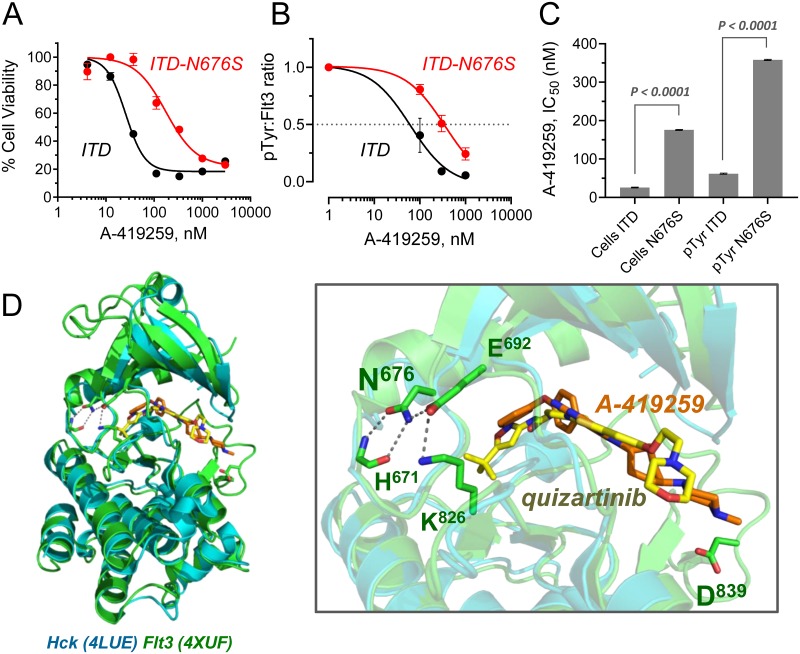
Flt3-ITD N676S mutation confers resistance to A-419259 in TF-1 cells.(A) TF-1 cells expressing Flt3-ITD or the Flt3-ITD N676S mutant were incubated over a range of A-419259 concentrations or the DMSO carrier solvent (0.1%) alone as control. Cell viability was determined 72 hours later using the CellTiter Blue cell viability assay. Results are shown relative to the DMSO control values, and IC50 values were determined by non-linear regression analysis of the resulting concentration-response curves. (B) Cell populations from part A were incubated overnight in the presence of the A-419259 concentrations shown. Flt3 was then immunoprecipitated and analyzed for phosphotyrosine (pTyr) content and Flt3 protein recovery by immunoblotting followed by Odyssey infrared imaging. The mean pTyr:Flt3 protein ratios ± SE for three independent experiments were fit by non-linear regression analysis. (C) The IC50 values for growth inhibition (Cells) and Flt3 phosphotyrosine context (pTyr) are shown, and were compared for statistical significance by Student’s t test. (D) Model of A-419259 bound to the Flt3 kinase domain. The crystal structure of the Flt3 kinase domain bound to quizartinib (PDB: 4XUF; green) was aligned with the crystal structure of the Hck kinase domain bound to A-419259 (PDB: 4LUE; blue) using PyMol. The overall alignment is shown at left, and a close-up of the inhibitor binding site is shown at right. Significant overlap was observed in the positions of quizartinib (yellow) and A-419259 (orange) in the ATP-binding site. In the Flt3 structure, residue Asn676 forms a local network of polar contacts with the side chains of Glu692, Lys826 and the main chain of His671. Acquired mutations in this residue were associated with resistance to A-419259 in AML cell lines. Whole exome sequencing also identified a substitution of Flt3-ITD Asp839 (shown) in MV4-11 population R3; this mutation was not verified in subsequent Sanger sequencing of individual clones (Table 1).